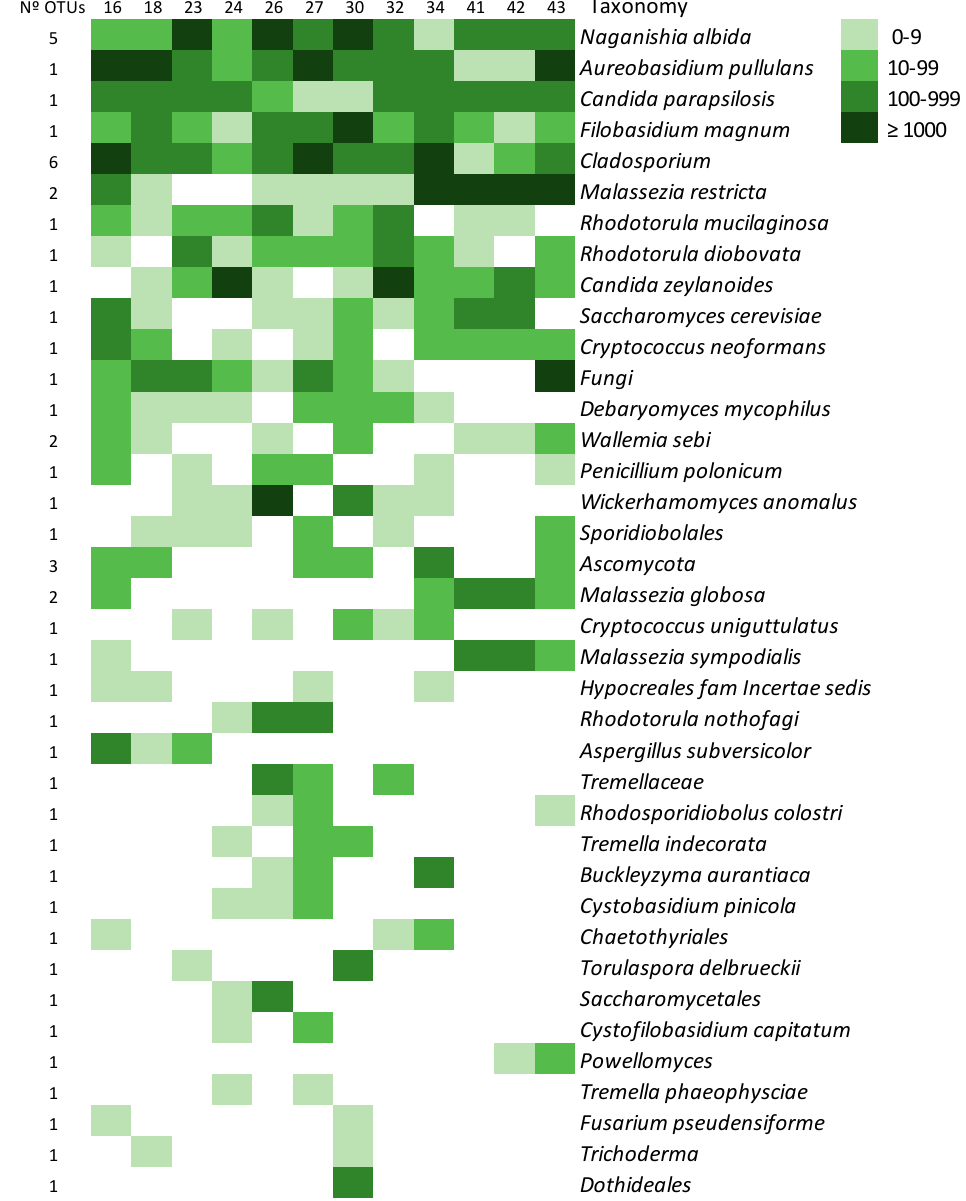
Figure 7. Distribution of fungal putative species detected in ENV samples. The intensity of the color corresponds with the number of sequences that showed a hit with the species in the UNITE database at 97% similarity (logarithmic scale). The column at the left shows the number of OTUs that corresponded to each of the putative species. The ones present in less than 10% of the samples and with less than 100 sequences are not shown.